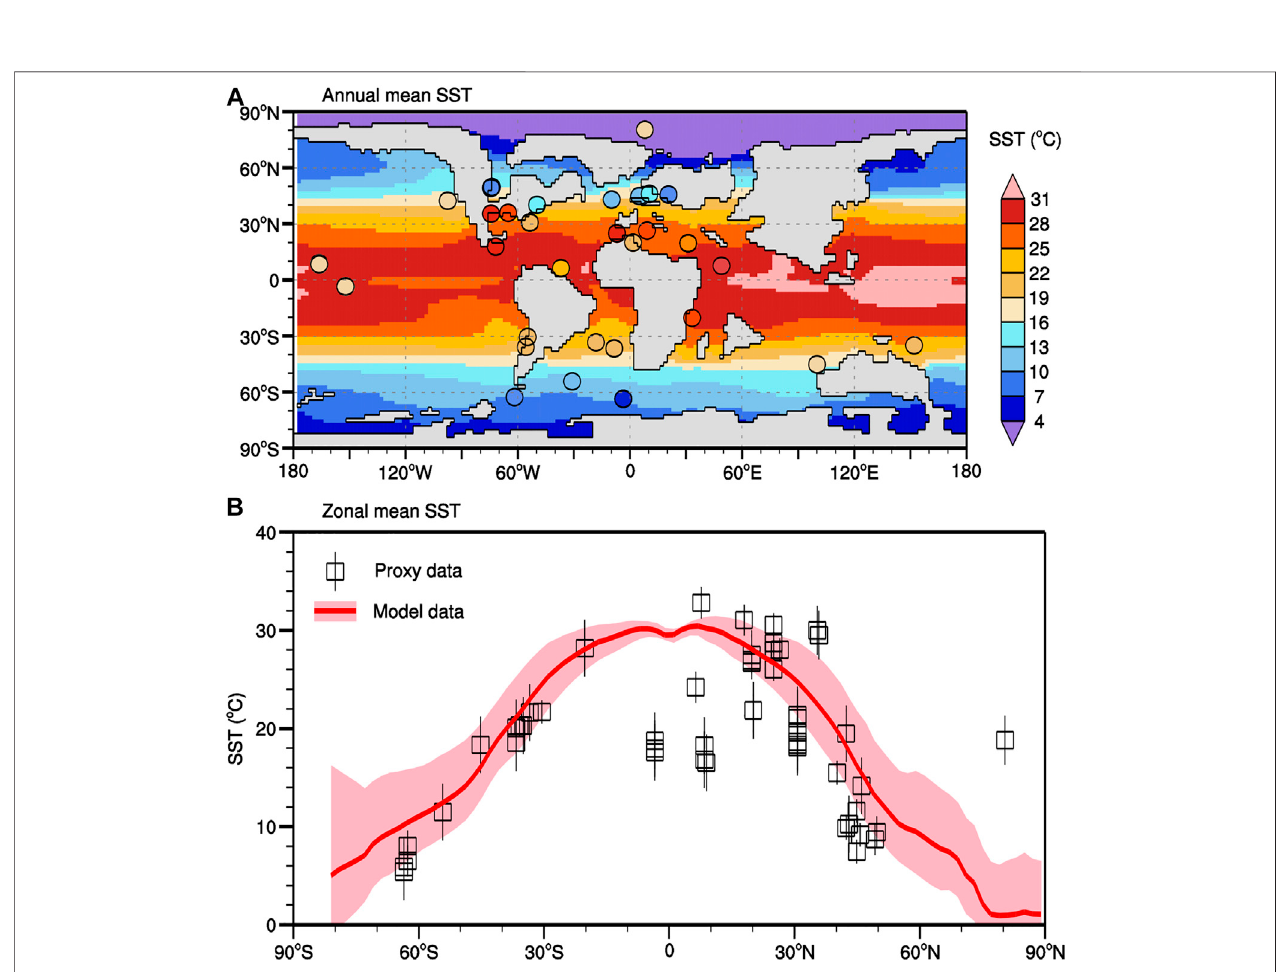
FIGURE 3 | Comparison of the annual-mean SST between model simulations (this study) and proxy data (Tabor et al., 2016). The proxy data are shown as fi lled circlesin (A) andblanksquaresin (B) wheretheoverlyingverticallinesrepresenttheiruncertainties.In (B) ,thezonalmeanSSTfromthemodeliscalculatedandindicated by the red lines, with the pink shading represents the simulated range of the monthly